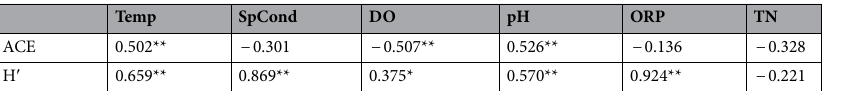
Table 2. Relationships between biodiversity and environment factors. **Significance at the level of 0.01; *Significance at the level of